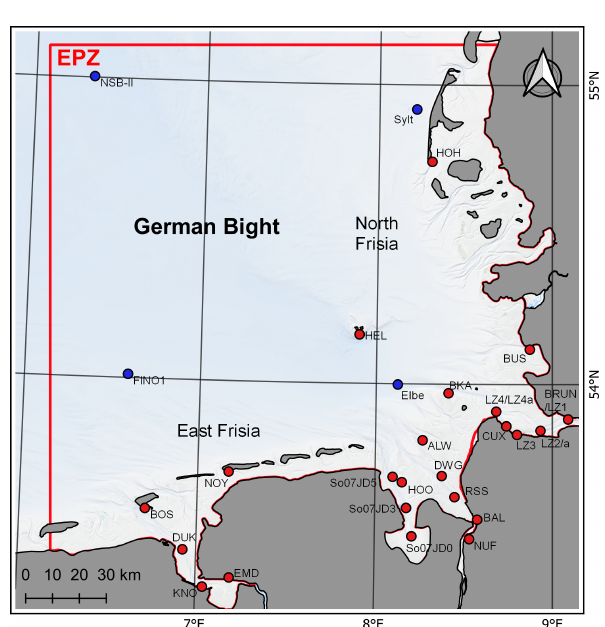
Figure 9. Gauge map in the German Bight showing the gauge lo- cations (red dots) and wave gauge locations (blue